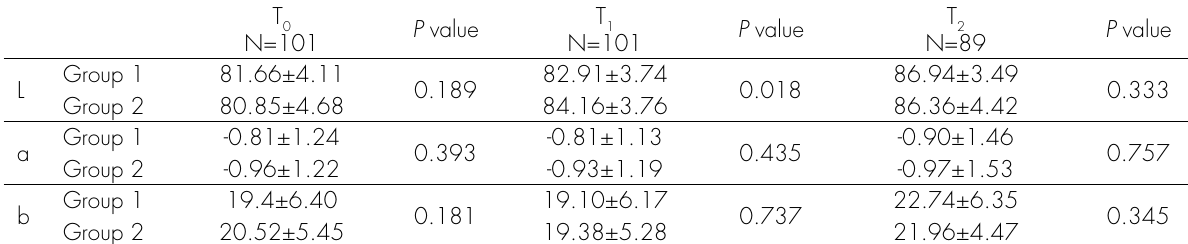
Table III. Inter group comparison of L, a and b values at T0, T1 and T2 between Groups 1 and 2 ( p <